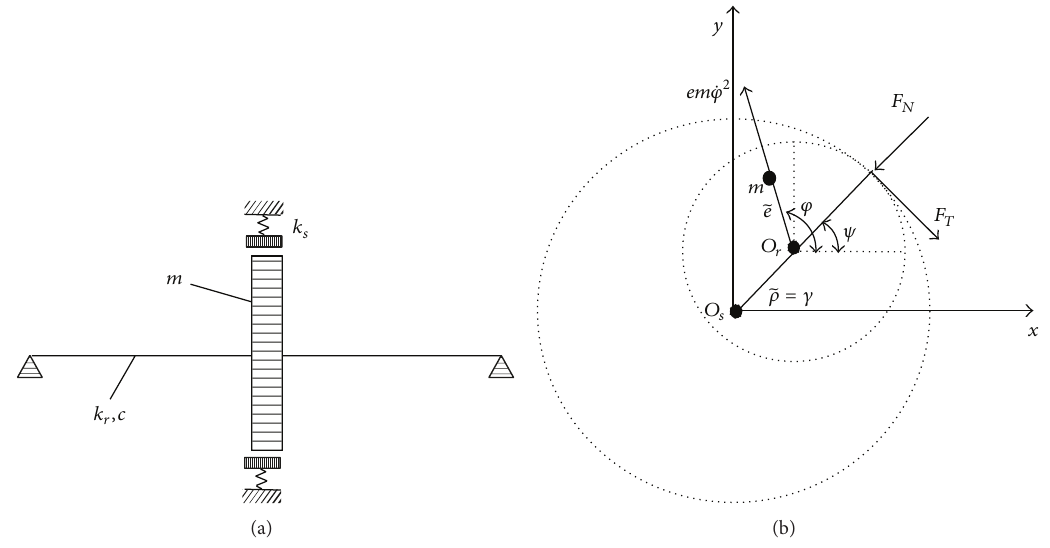
Figure 1: (a) The schematic plot of the rotor-to-stator system; (b) the section view on the plane of the rotor and the stator ring.